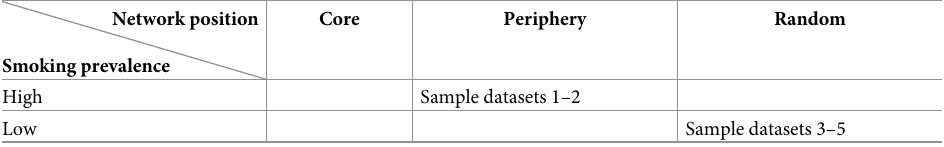
Table 5. Crosstab of smoking prevalence and network positions of